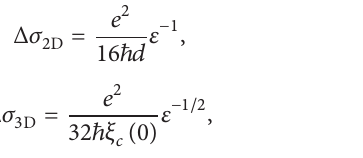
≈ −0.5 (3D regime) and tan 𝛼 ≈ −1 (2D regime). The 2 D D